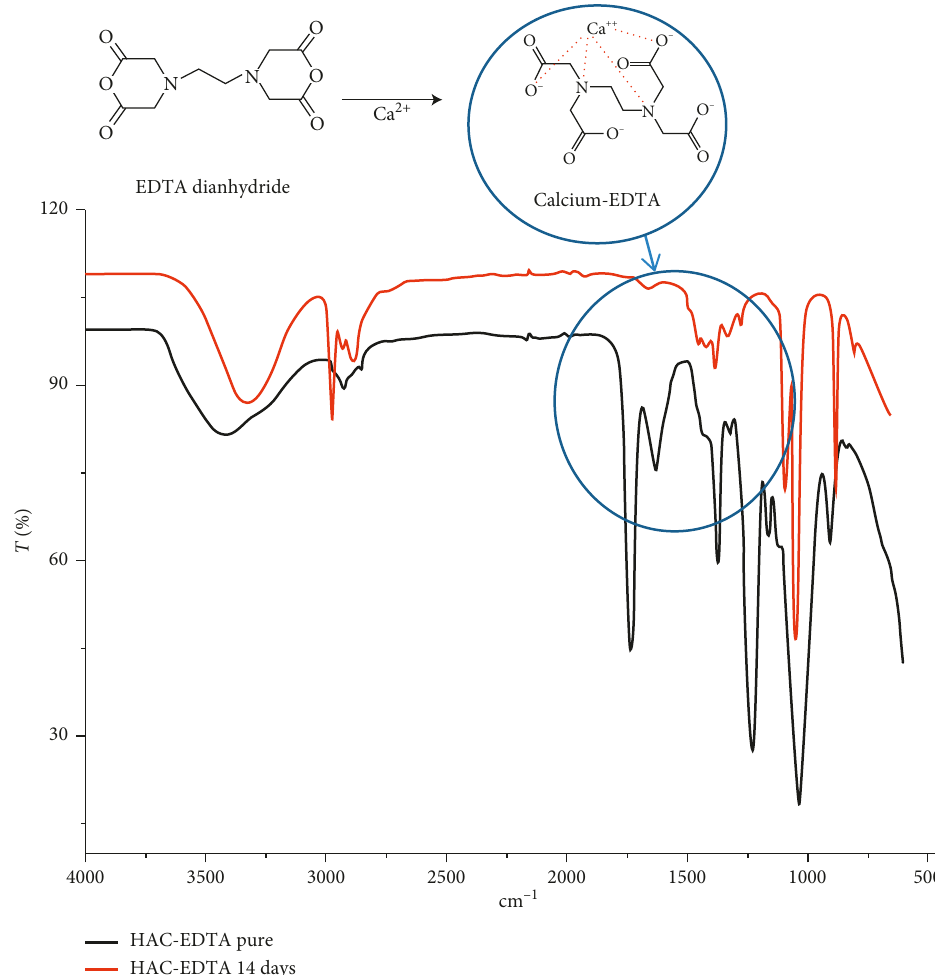
Figure 5: Schematic of interaction of calcium with HAC-EDTA, showing a disappearance of 1626cm − 1 band at approximately 1400cm − 1